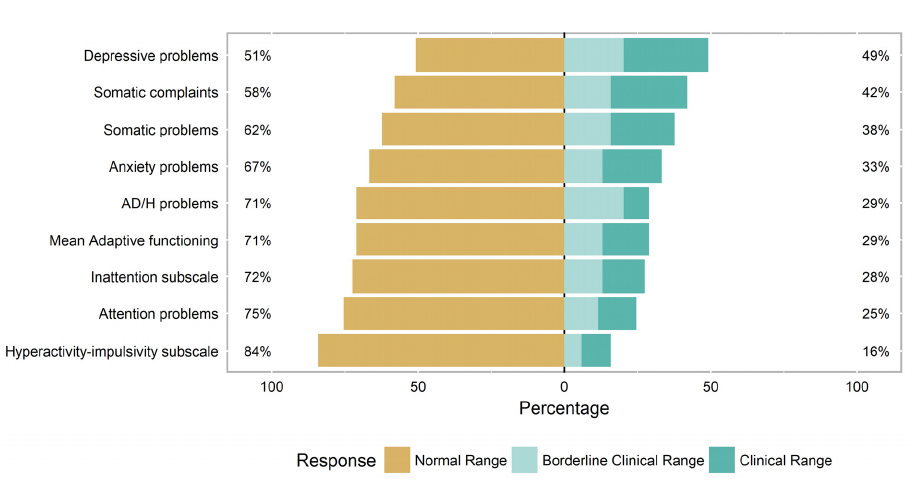
Figure 1. Prevalence of ASEBA symptoms in adults with Fabry disease. Among the twenty subjects endorsing symptoms within the borderline-clinical-to- clinical range on the AD/H scale, the source of those scores was almost equally balanced between the symptomatic endorsement of AD items, H-I items, and combined AD/H items, with a final three subjects whose endorsement of items was evenly split such that they fell within the normal ranges on the individual subscales while still falling within the symptomatic range on the overall combined AD/H scale (Table 2). All subjects endorsing